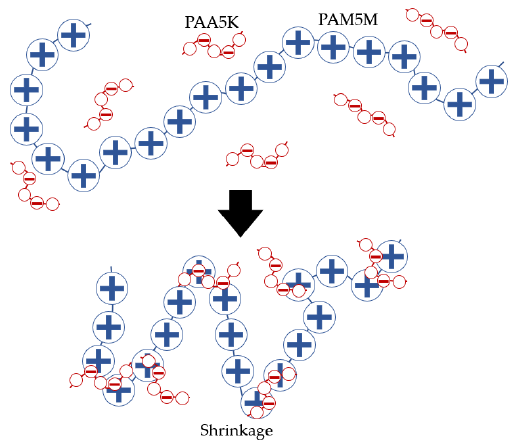
Figure 10. Schematic representation of conformational changes of PAM5M upon the adsorption of PAA5K.